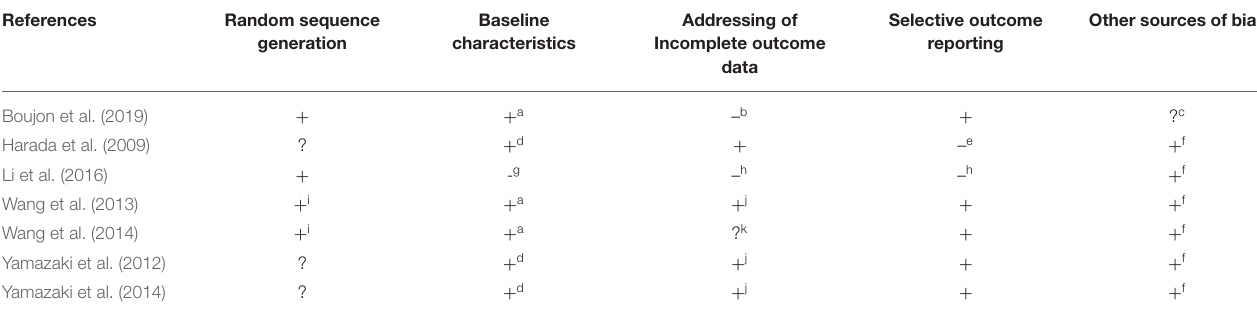
TABLE 2 | Risk of bias assessment.